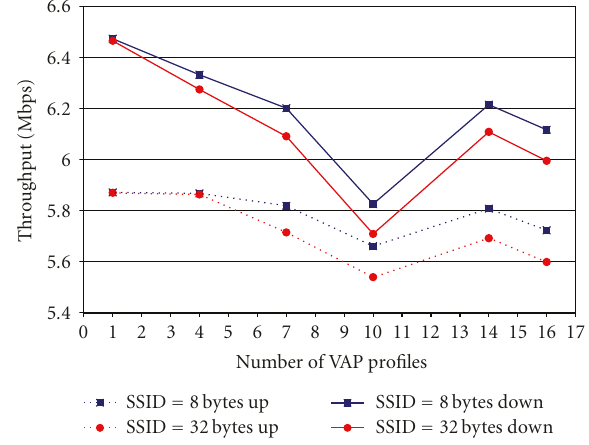
Figure 21: Throughput versus number of VAP profiles with SSID length as a